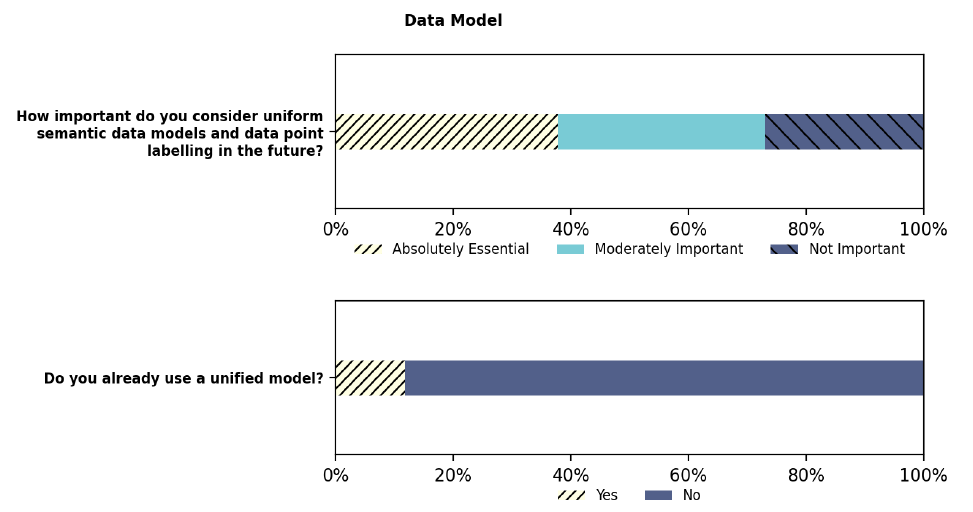
Figure 2. Responses to a survey questions to assess the importance of data